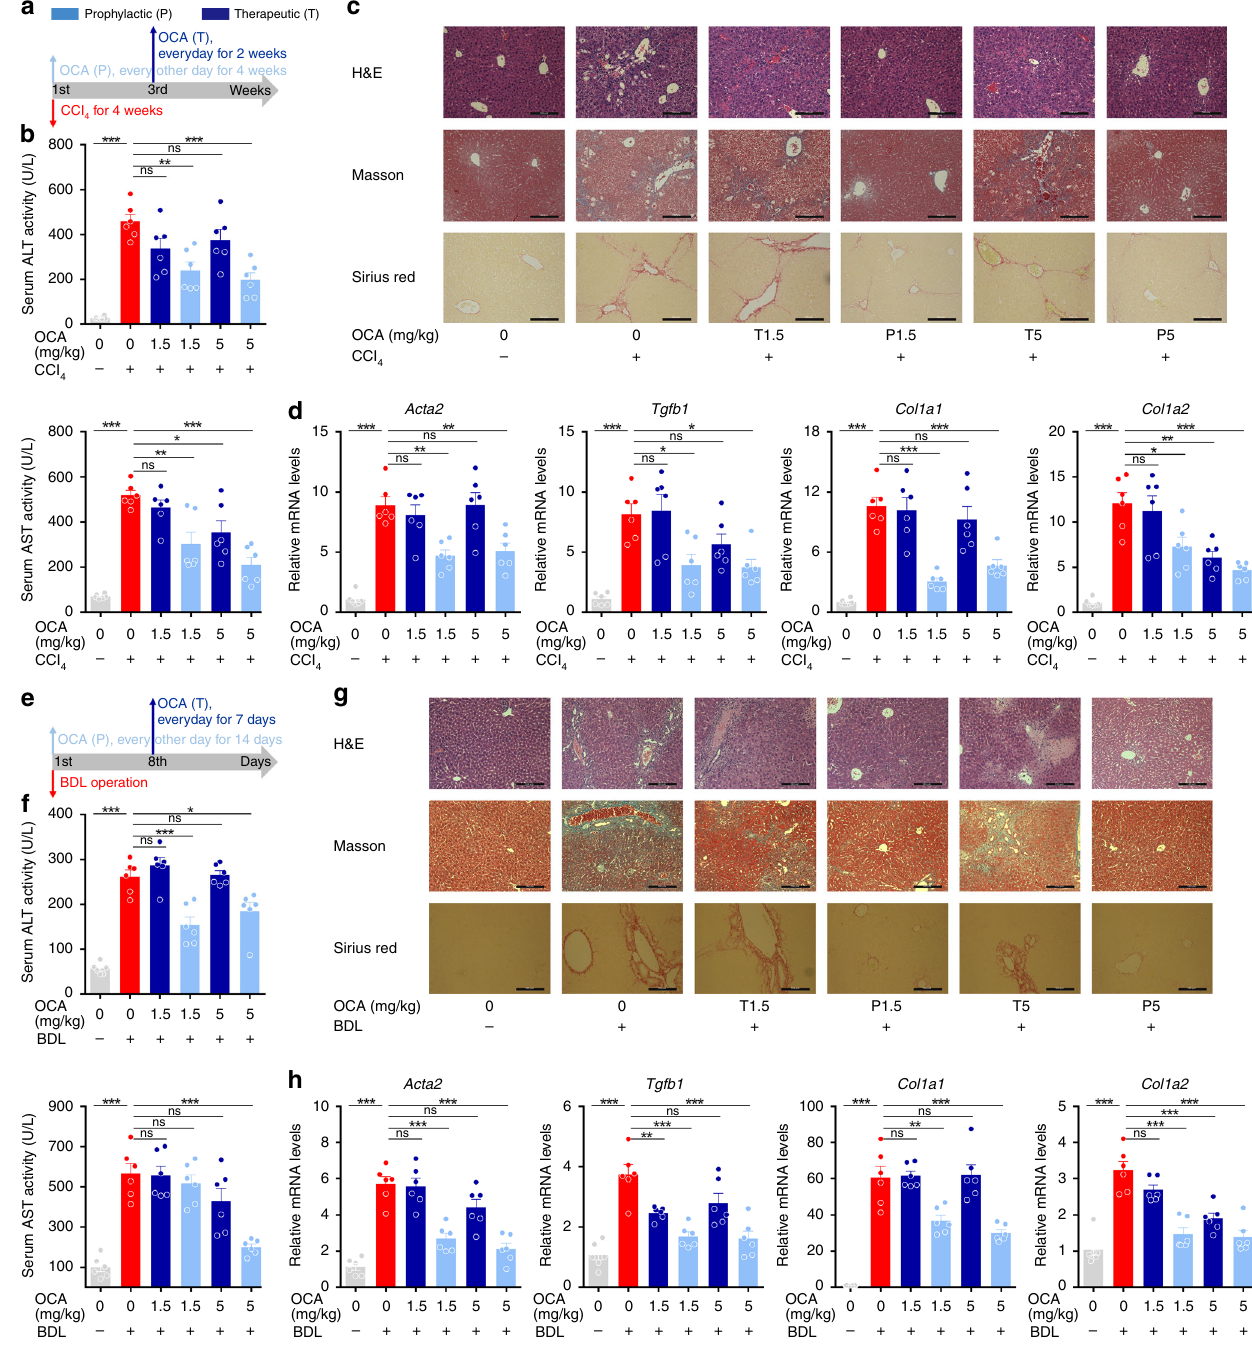
Fig. 1 Prophylactic but not therapeutic administration of OCA alleviates liver fi brosis. The anti- fi brotic effects of prophylactic and therapeutic administration of OCA were evaluated in CCl 4 -induced a – d or BDL-induced e – h liver fi brosis models. a and e Mouse experiment procedure schemes. b and f Serum ALT and AST levels. c and g H&E, Masson and Sirius red staining of liver sections. Data are representative of n = 6 biological independent samples. Scale bar, 100 μ m. d and h Levels of Acta2 , Tgfb1 , Col1a1 , and Col1a2 mRNAs in liver. n = 6 biologically independent samples within these experiments. Results are mean ± SEM, * P < 0.05, ** P < 0.01, *** P < 0.001, and ns, statistically not signi fi cant, as assessed with